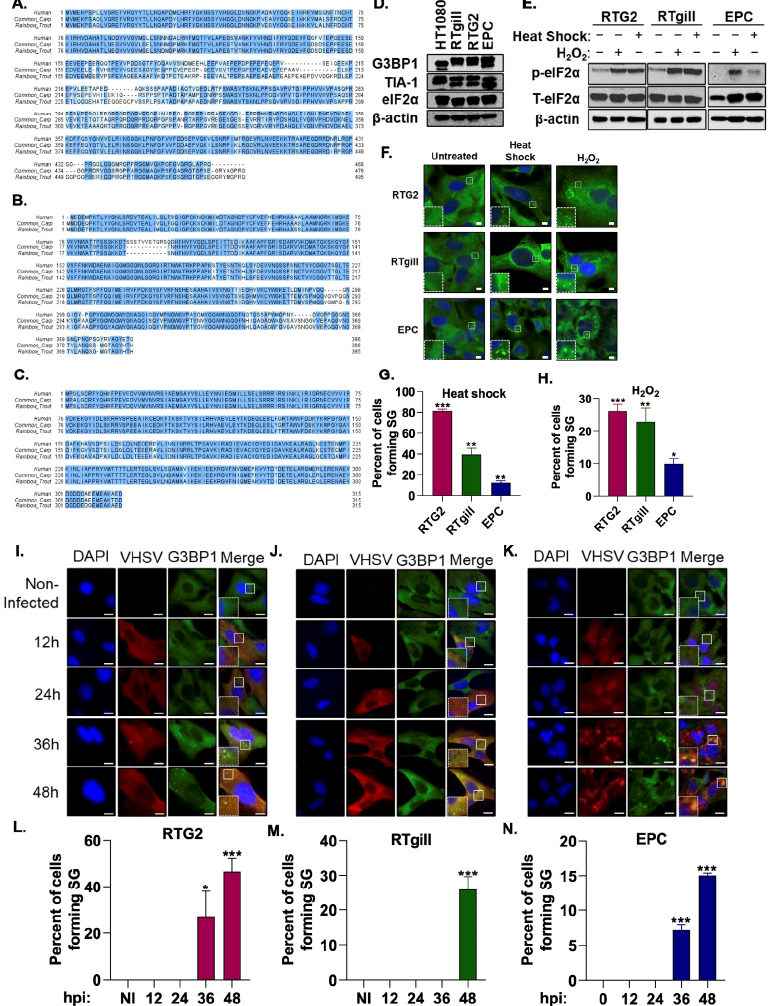
Figure 1. VHSV infection induces stress granule formation. Multiple amino acid sequence alignments of human, common carp and rainbow trout ( A ) G3BP1 ( Homo sapiens , Q13283; Cyprinus carpio , XP_018929741; Oncorhynchus mykiss , XP_021417518;), ( B ) TIA-1 ( Homo sapiens , P31483; Cyprinus carpio , KTF92398; Oncorhynchus mykiss , XP_021457804), ( C ) eIF2 α ( Homo sapiens , P05198; Cyprinus carpio , XP_018935983; Oncorhynchus mykiss , XP_021429557). Identical amino acids are highlighted with dark blue and similar amino acids are with light blue color. ( D ) Cell lysates of HT1080 (human fibrosarcoma), RTgill, RTG2 (rainbow trout) and EPC (Fathead minnow) cells were analyzed by immunoblotting with antibodies against G3BP1, TIA-1 and eIF2 α . β -actin was used as loading control. RTG2, RTgill and EPC cells were subjected to heat shock (37 ◦ C, 1 h), or oxidative stress (5 mM H 2 O 2 , 3 h) and ( E ) phosphorylation of eIF2 α in cell lysates was analyzed by immunoblotting, or ( F ) cells were fixed and stained with anti-G3BP1 antibodies to monitor stress granules and DAPI to stain the nucleus and ( G , H ) percent cells forming stress granules were quantitated. RTG2 ( I , L ) and RTgill ( J , M ) cells were infected with VHSV Ia and EPC ( K , N ) cells were infected with VHSV IVb (MOI = 1 pfu/cell) at indicated times hpi cells were fixed and stained with G3BP1 and anti-VHSV antibodies. (L-N) Percent cells forming SG were quantitated. Data represents mean ± SD. Scale bar 1 µ m; * p < 0.05; ** p < 0.01; *** p <